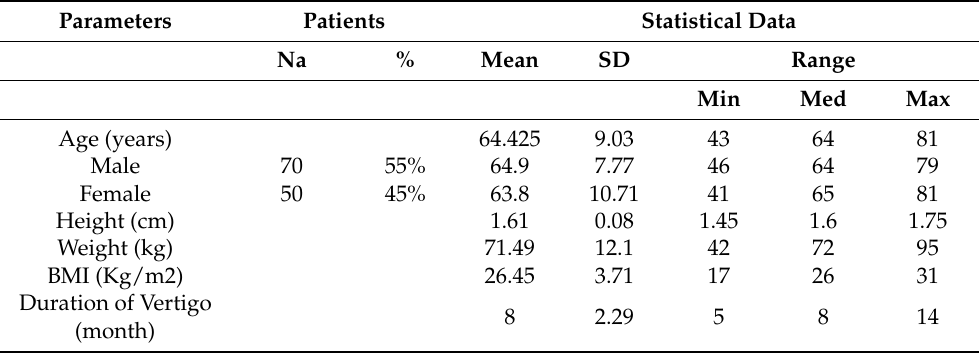
Table 1. Demographic data and other baseline characteristic of patients included in the